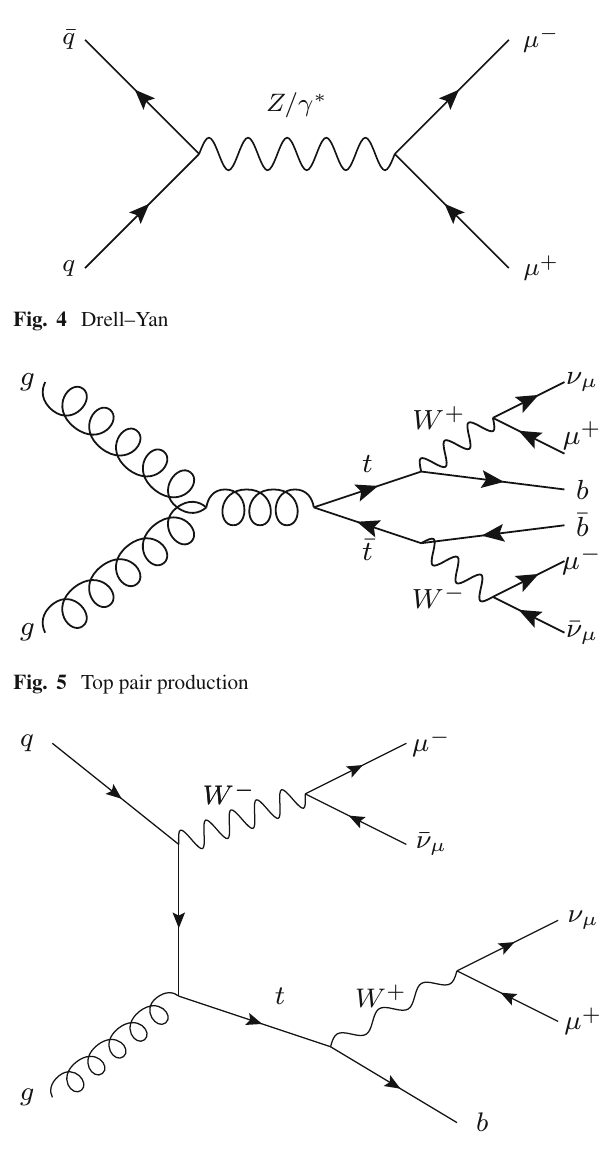
Fig. 6 Single top production